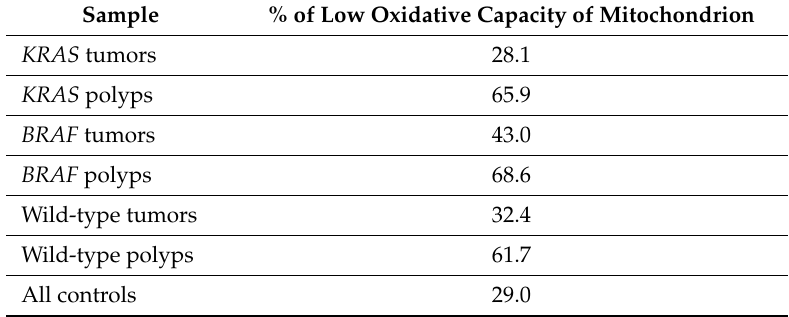
Table 1. Modelled percentage of low oxidative capacity of mitochondrion in KRAS + , BRAF + and wild-type tumors and